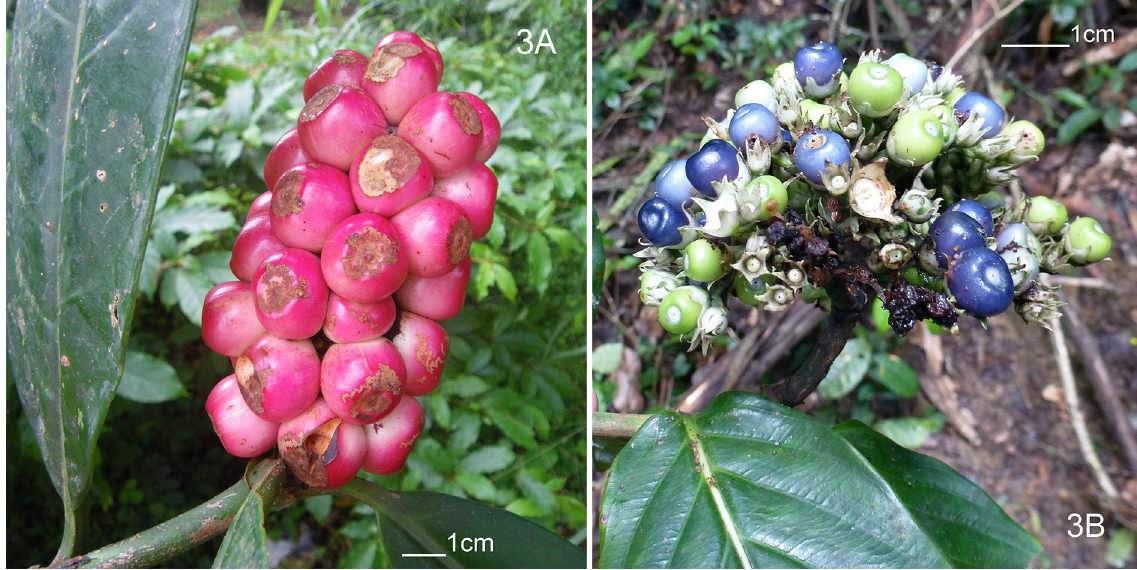
Fig. 3. A . Gaertnera spicata fruits. B . Gaertnera cooperi fruits. A from Lachenaud & Walters 1163